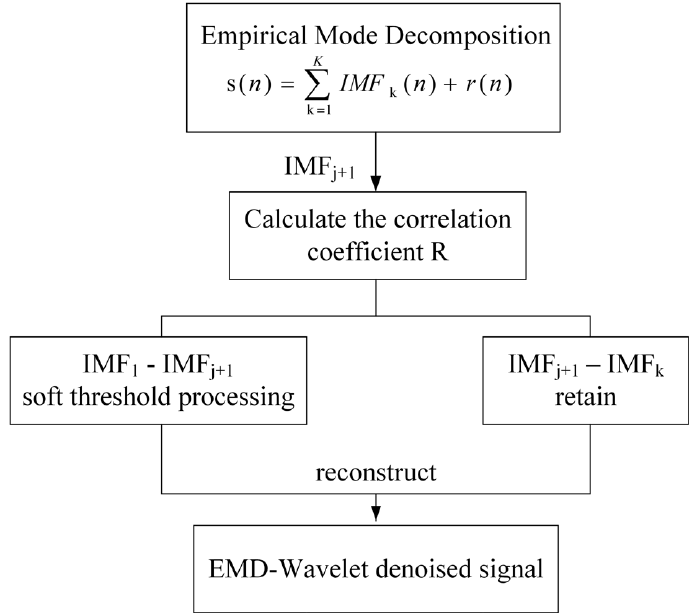
Figure 8. The flow chart of EMD-Wavelet threshold denoising. Table 1 lists the calculated IMF component correlation coefficients of each component signal. In this table, IMF 4, IMF 4 and IMF 3 are the transition components of H x , H y , and H z after EMD